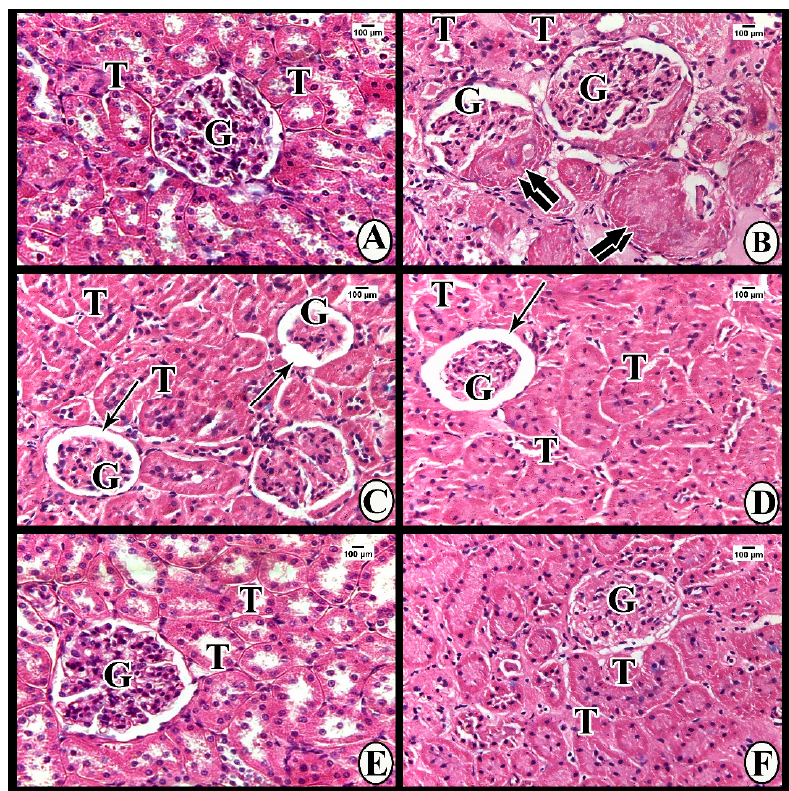
Figure 4. ( A ) Hematoxylin and eosin (H&E) stained sections of renal tissue of Group I show normal glomerulus (G) and tubules (T). ( B ) Group IIa shows mesangial expansion in the glomeruli (G) and glomerular nodular sclerosis (double arrows). Tubules (T) show obliterated lumens and darkly stained nuclei with loss of nuclear polarity. ( C, D ) Groups IIb and III demonstrate shrunken glomeruli (G) with wide Bowman’s spaces (thin arrows). The tubules (T) show swollen epithelial lining obliterating the lumens in addition to darkly staining nuclei with loss of polarity. ( E ) Group IV shows decreased mesangial expansion in the glomeruli (G). Tubules (T) have open lumens and normal nuclear polarity. ( F ) Group V shows persistent mesangial expansion in the glomeruli (G), swollen tubular epithelia (T) obliterating the lumens, and darkly stained nuclei with loss of polarity.